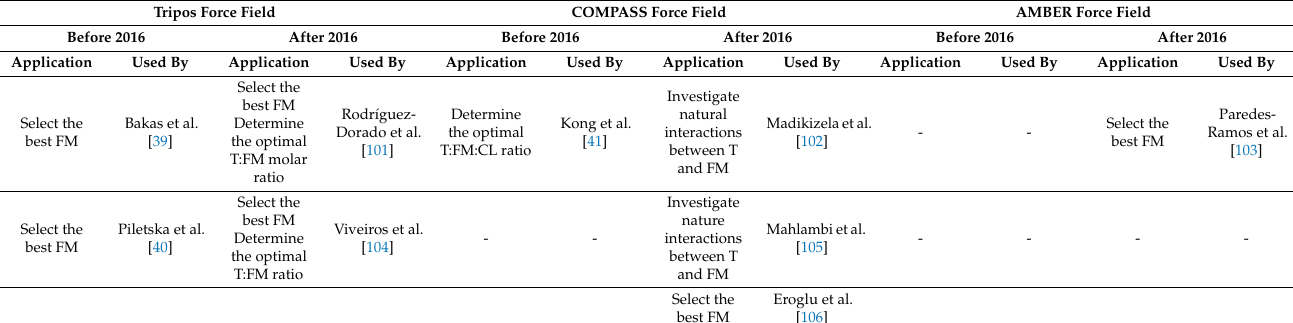
Table 9. Comparison of the molecular dynamics approach to design molecularly imprinted polymers (MIPs) before and after